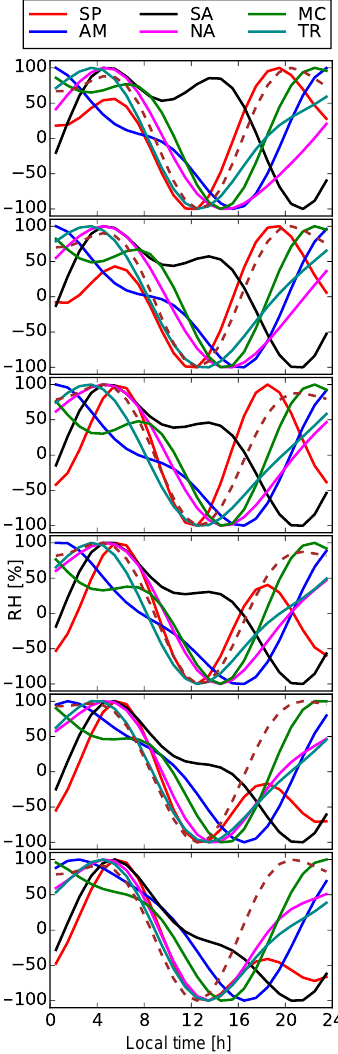
Figure 17. Diurnal cycle of layer-averaged RH I as well as Fourier series fit for the selected regions. Depicts from top to bottom are for SAPHIR channels 1–6, respectively. The legend shows the name of the regions which are defined in Table 2. The dashed lines show a grid box with a large difference between the measurements (pen- tagons) and the fit for the Fourier series (the dashed-line). The lon- gitude and latitude of this grid-box are printed on the top plot.